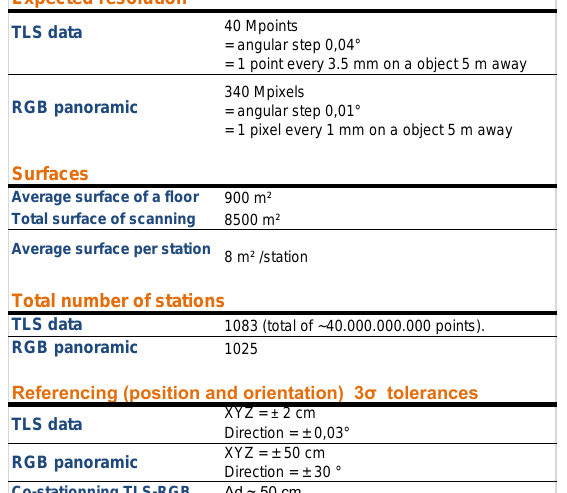
Table 1 : Key numbers of the characteristics of the scanning campaign performed in 2013 at EDF.